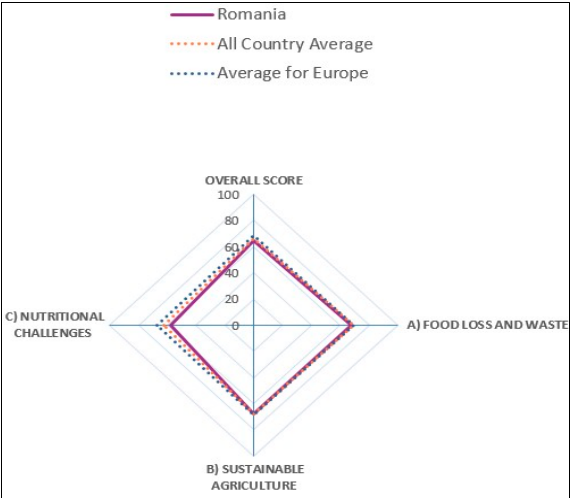
Figure 2. Romania’s food sustainability index, 2018 [18].